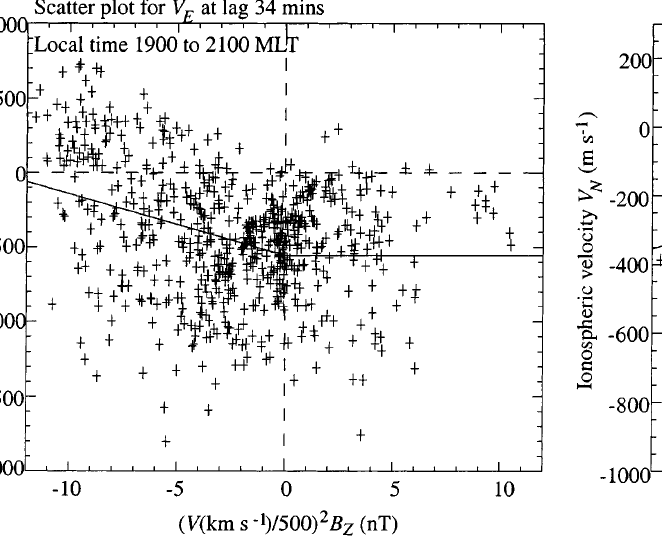
Fig. 4. f As for a except for the 2-h interval centred on